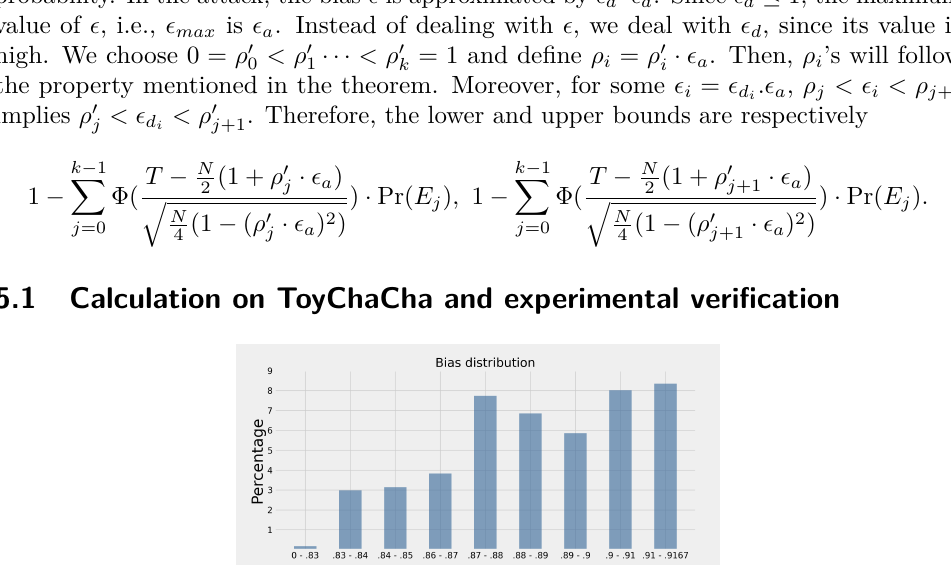
Figure 1: Bias distribution in Toy ChaCha for ( ID , OD ) pair (∆ (0) rounds in [AFK +